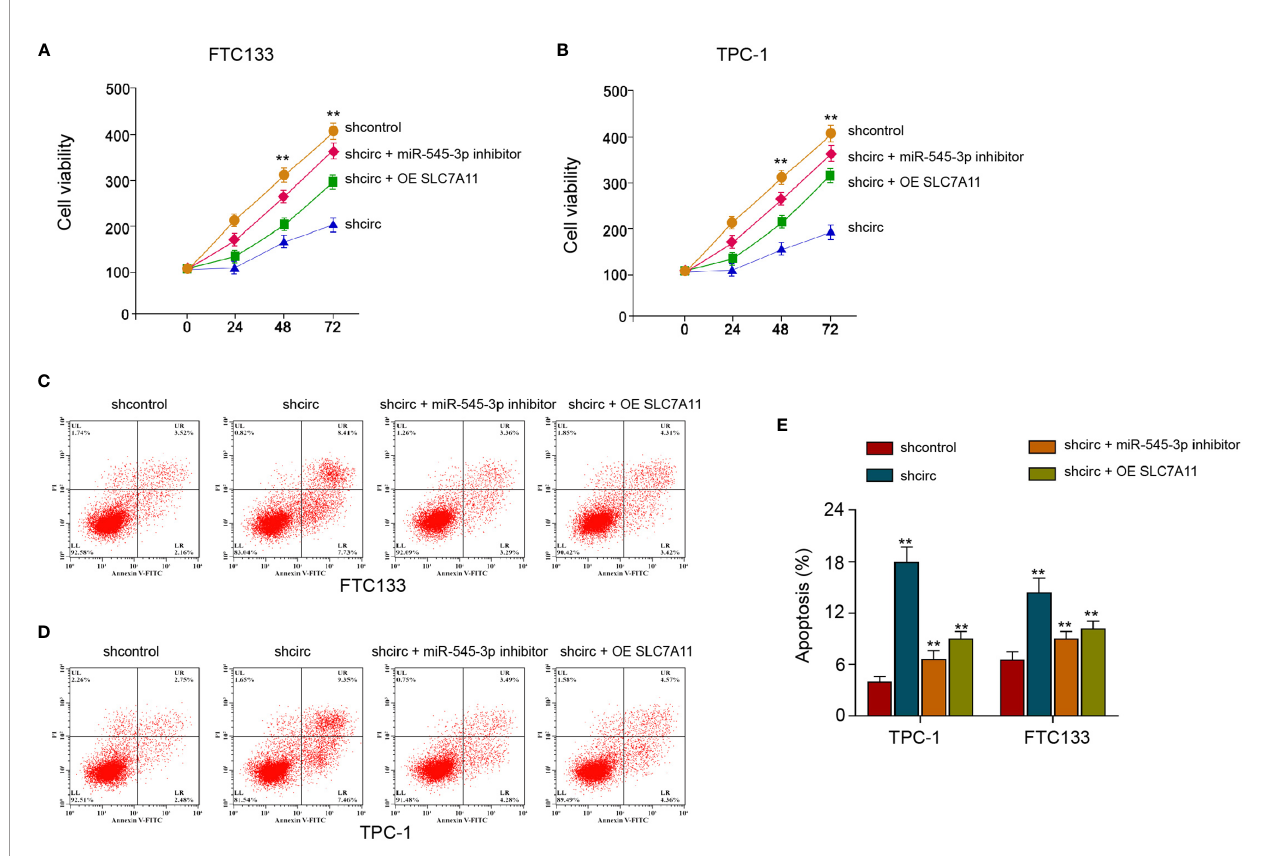
FIGURE 8 | SLC7A11 re-constitution and miR-545-3p inhibitor reverse circ_0067934-inhibited thyroid cancer cell growth. (A, B) The analysis of FTC133 and TPC-1 cell viability by MTT assays. (C – E) Apoptosis analysis of FTC133 and TPC-1 cells by fl ow cytometry. mean ± SD, ** P <